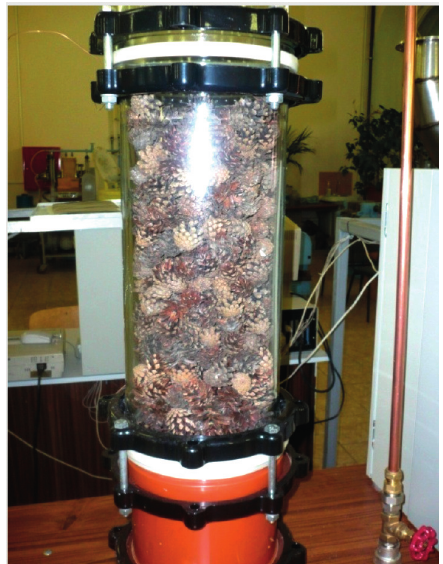
Fig. 2. Installation general